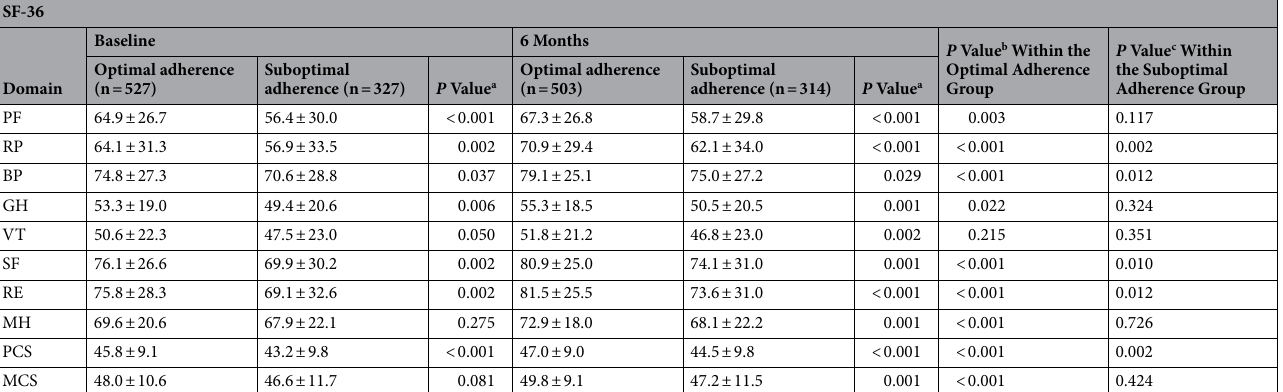
Table 2. Comparison of SF-36 scores between the optimal adherence and suboptimal adherence groups at baseline and at the 6-month follow-up. Data are presented as number (%) or mean ± standard deviation. BP, bodily pain; GH, general health; MCS, mental component summary; MH, mental health; PCS, physical component summary; PF, physical functioning; RE, role emotional; RP, role physical; SF, social functioning; SF-36, 36-Item Short Form Health Survey; VT, vitality. a P values for the difference between the adherence groups were calculated using the Student’s independent 2-sample t -test. b P values for the difference within the optimal adherence group were calculated using a paired t -test. c P values for the difference within the suboptimal adherence group were calculated using a paired t